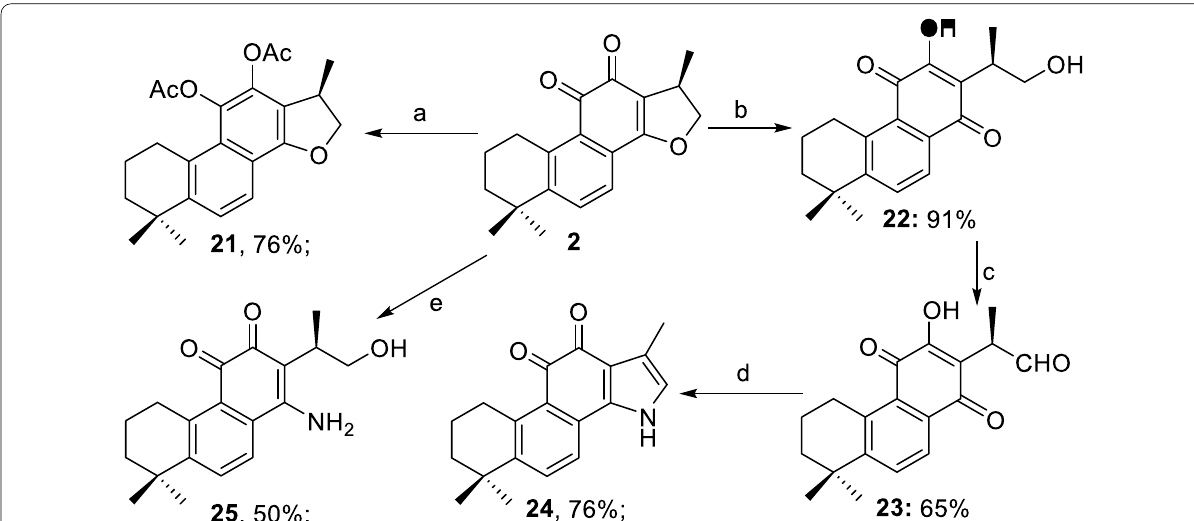
Scheme 3 Modifications on C‑ and D‑rings of 2 . Reagents and Conditions: a) H 2 , PtO 2 , Ac 2 O, Pyridine, THF, rt; b) NaOH (2.0 M), THF/H 2 O, ultrasound; c) IBX, DMSO, rt; c) NH